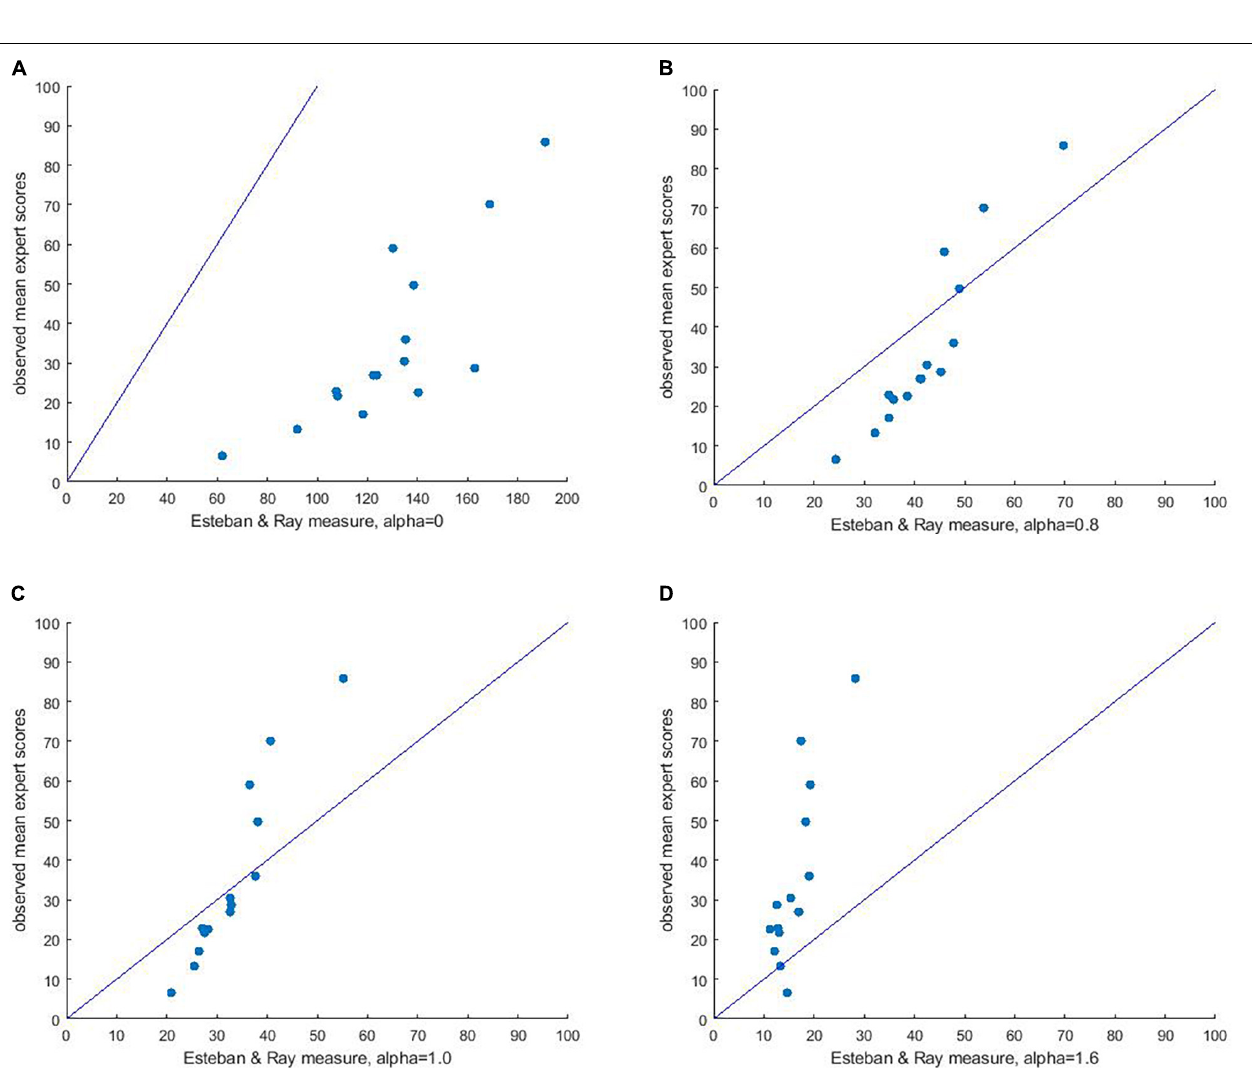
Frontiers in Psychology |